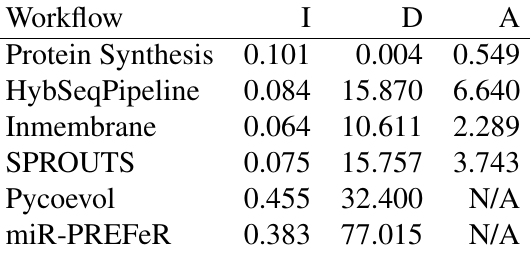
Table 4: WISE performance (in seconds) recorded for the production of the instrumented work- flow (I), its dataflow (D) and its abstraction